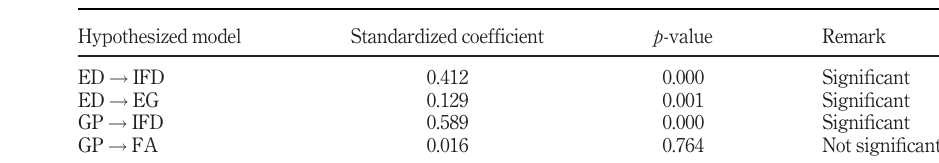
Table 4. Path model and direct effects